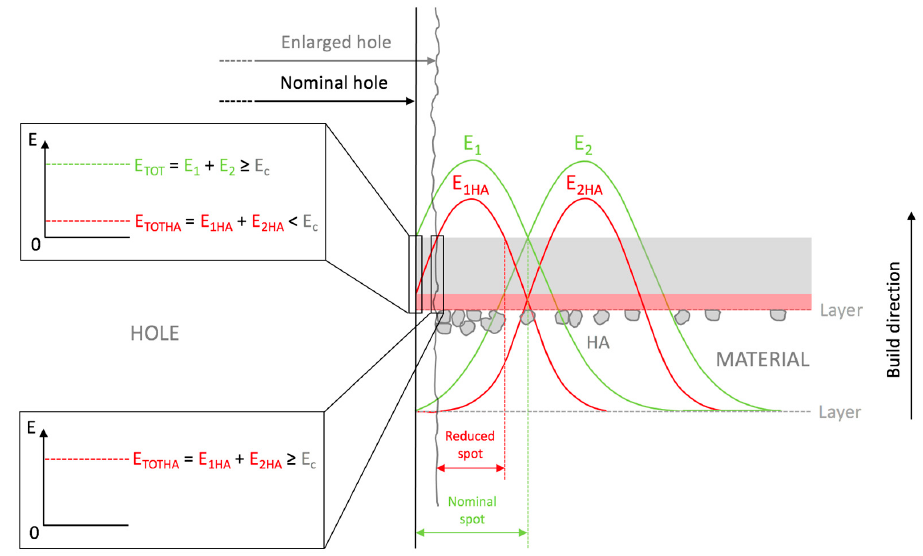
Figure 6. The presence of HA may partially diminish the absorbed energy; therefore, the material under the periphery of the spot may not have reached an energy value such as to trigger polymerization.